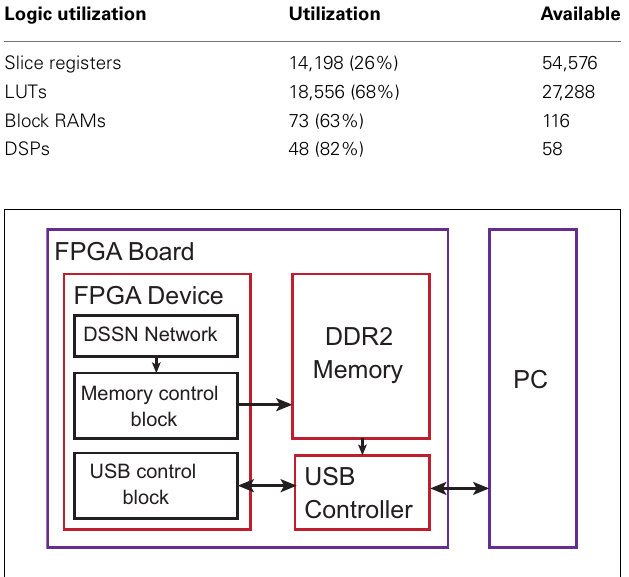
FIGURE 7 |The architecture of the whole system.